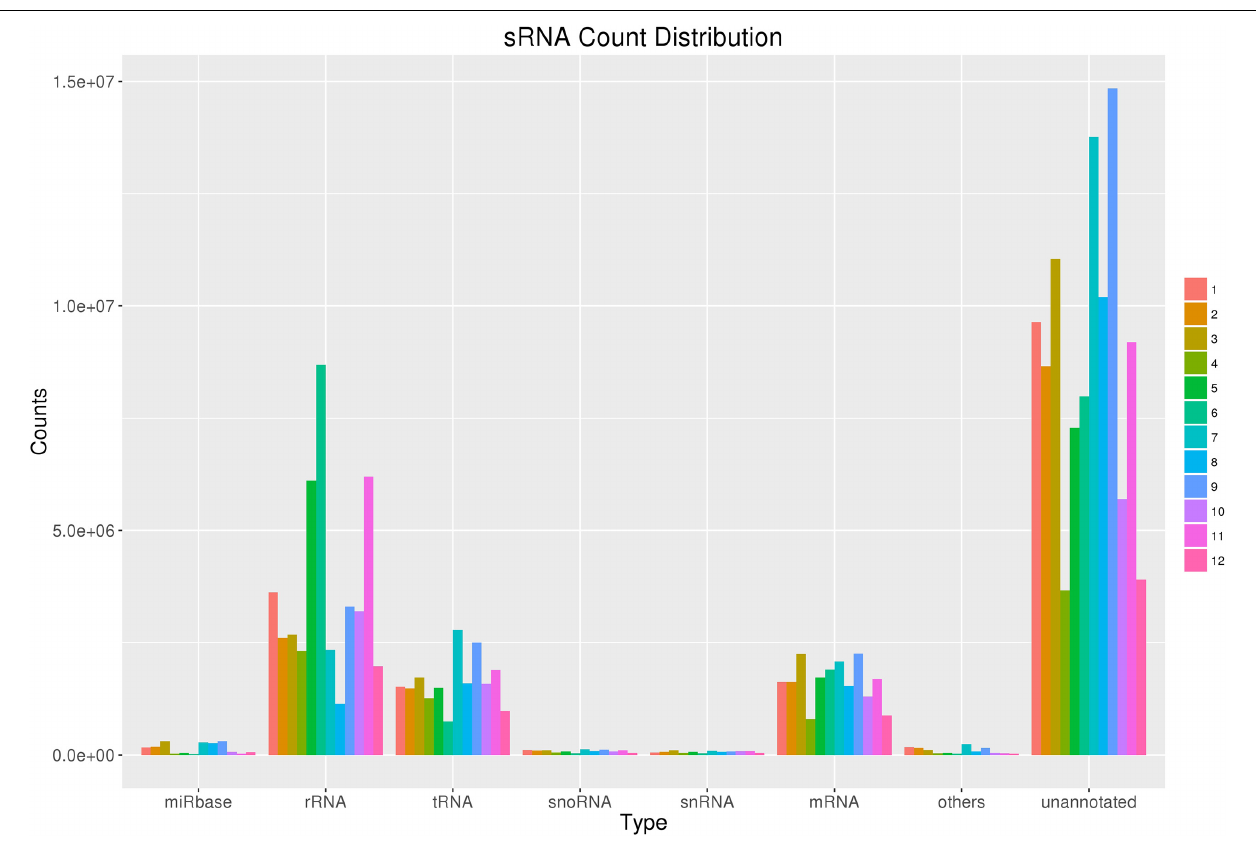
FIGURE 1 | sRNA count distribution. Count distribution of different RNA categories in all 12 samples from four groups. sRNAs were categorized into multiple groups according to their biological classification. The first category “miRbase” indicates annotated some RNAs using the miRbase database.